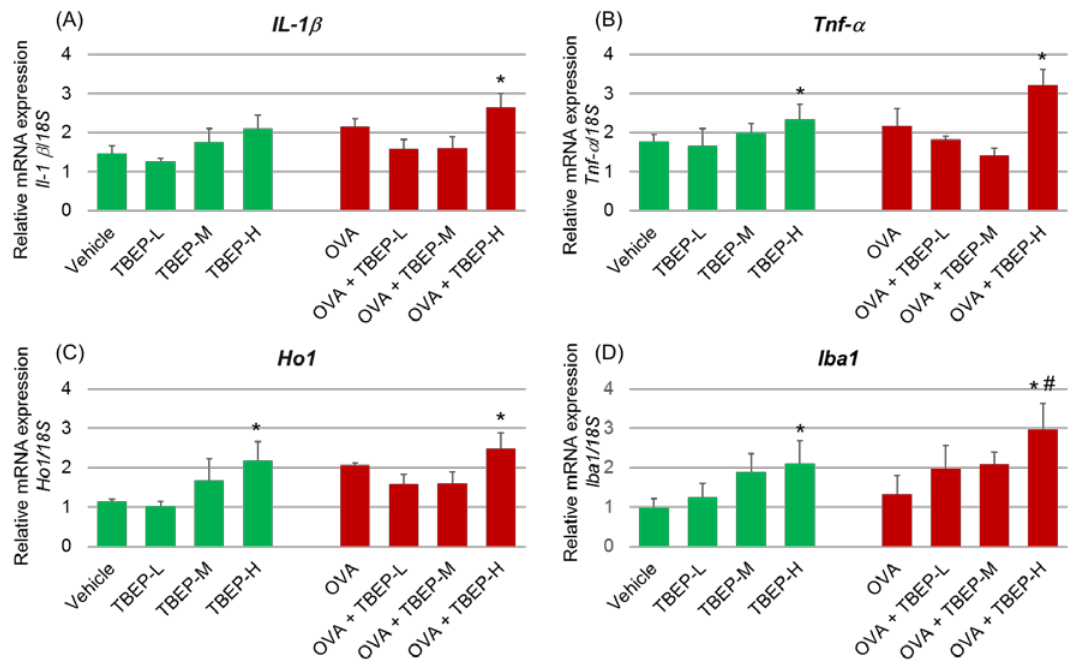
Figure 4. Messenger RNA expression levels of inflammatory molecular markers. ( A ) Il-1 β , ( B ) Tnf- α , ( C ) Ho1 and ( D ) Iba1 mRNA in the hippocampus of TBEP-exposed male mice with or without OVA immunization. (n = 6, * p < 0.05 vs. vehicle alone; # p < 0.05 vs. OVA alone).